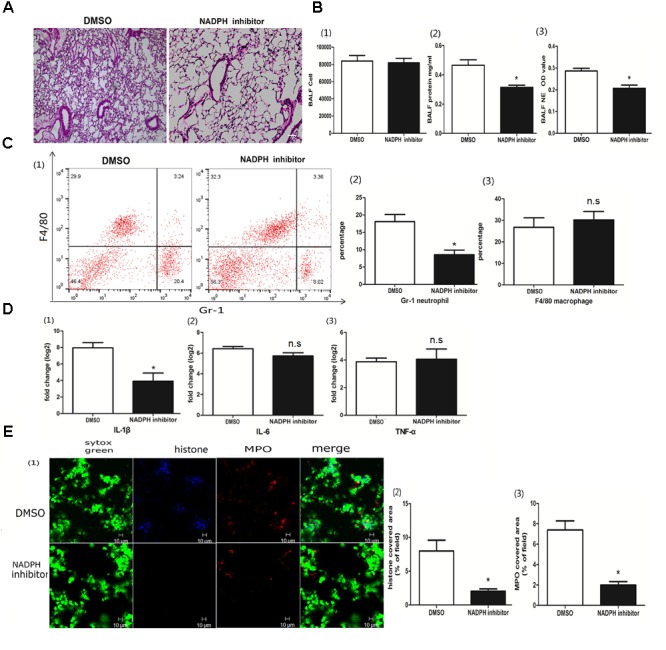
NADPH was associated with poly I:C-induced NETs. (A) Infiltration of inflammatory cells and interstitial edema in the lung lobe were inhibited in the ALI mice treated with an NADPH inhibitor, bar = 100 μm; (B-1) cells were counted in the BALF, ∗p < 0.05; (B-2) protein concentration in the BALF, ∗p < 0.05; (B-3) neutrophil elastase (NE) activity was were evaluated in the BALF, ∗p < 0.05; (C) flow cytometry analysis of the BALF cells, ∗p < 0.05; (D) inflammatory cytokines IL-1β, IL-6, and TNF-α in the lung were quantified using qRT-PCR, ∗p < 0.05; (E) NETs were observed and quantified in the lung tissues from mice administered poly I:C and an NADPH inhibitor.